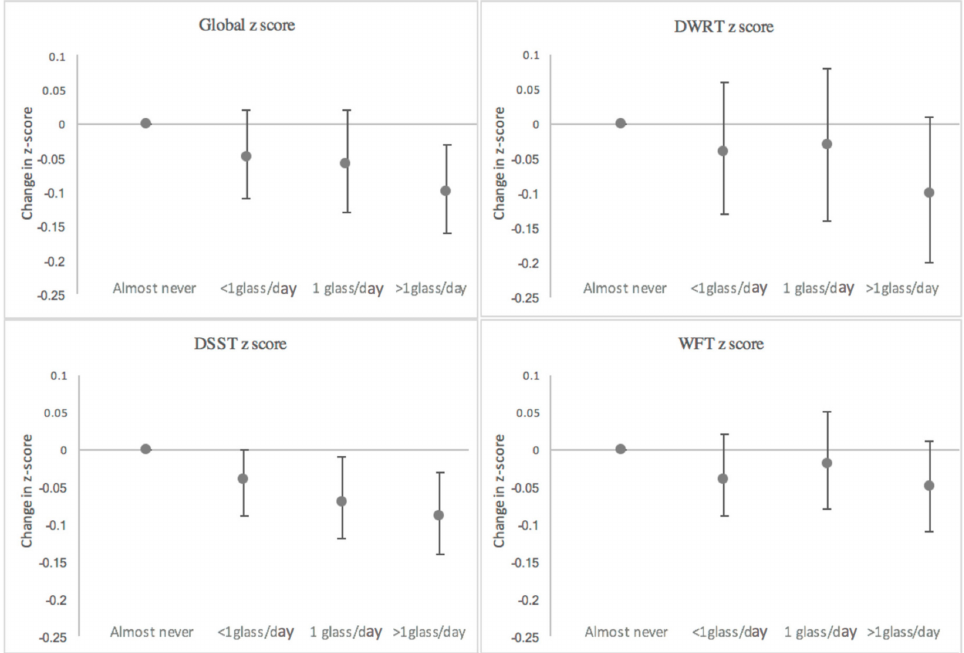
Figure 2. Estimated difference in the 20-year change in cognitive performance by milk intake group relative to those who reported “almost never” consuming milk adjusted for age, gender, race-center, education level, APOE4, BMI, smoking, alcohol intake, diabetes, physical activity, total energy intake and diet quality score. ARIC Study. Abbreviations: DWRT, delayed word recall test; DSST, digit symbol substitution test; WFT, word fluency test. Global z is a summary score, equal to the average of the three domain-specific